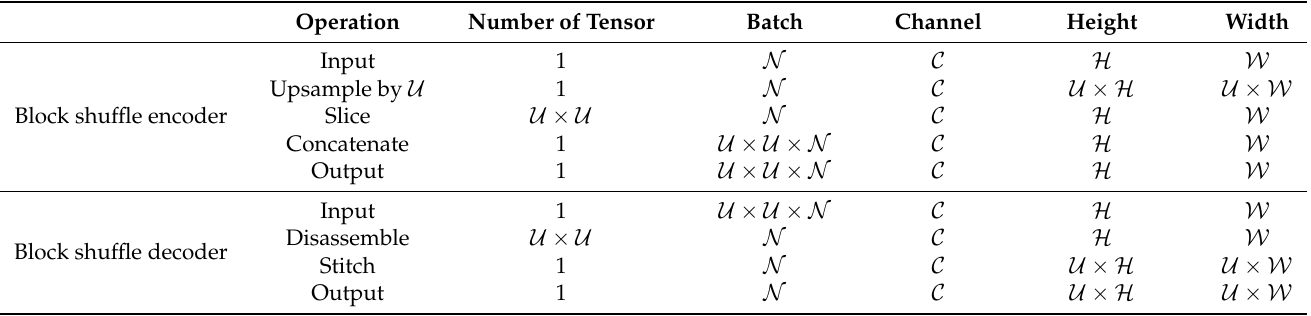
Figure 5. Details of the block shuffle encoder and decoder. Since the input data of the decoder consitute the high-level feature map, we use gray blocks to represent the feature map. Table 1. Feature tensor shape in block shuffle encoder and block shuffle